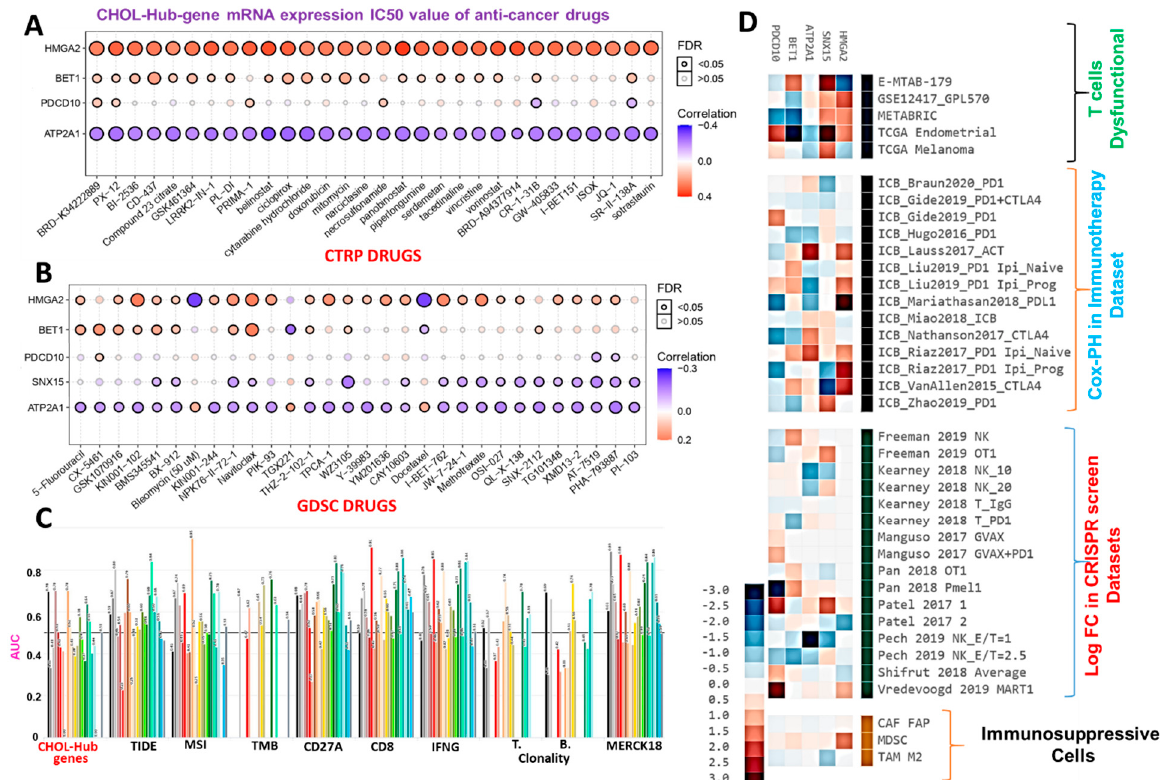
Figure 7. Cholangiocarcinoma (CHOL)-hub genes exhibited different associations with the sensitivity of cancer cells to anticancer therapy. Bubble plot of correlations of mRNA expression levels of hub genes with ( A ) CTRP and ( B ) GDSC drug sensitivities. Colors from blue to red represent correlations between mRNA expressions and IC 50 values of small-molecule drugs. A positive correlation means that the gene’s high expression was resistant to the drug and vice versa. The bubble size was positively correlated with the false discovery rate (FDR) significance. The black outline border indicates an FDR of <0.05. ( C ) Bar plot of the comparative biomarker relevance between the CHOL-Hub genes and standardized biomarkers. ( D ) Heat map depicting the association between the CHOL hub genes and outcomes of ICB therapy, T-cell dysfunctional and exclusion markers, and T cell-mediated tumor killing in CRISPR screens, CAFs; cancer-associated fi- broblasts; MDSCs; myeloid-derived suppressor cells; M2-TAMs; M2 subtype of tumor-associated macrophages.